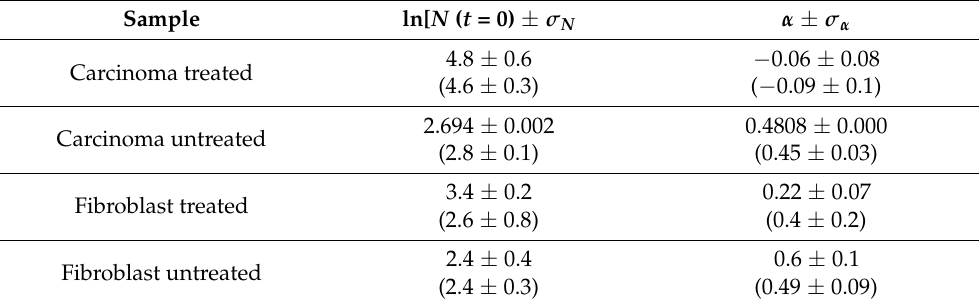
Table 3. Values of α obtained from a linear regression analysis to a log–log plot according to a power function model for cell growth as a function of time in the region of maximum growth. Values of α that correspond to the total time scale studied are indicated in